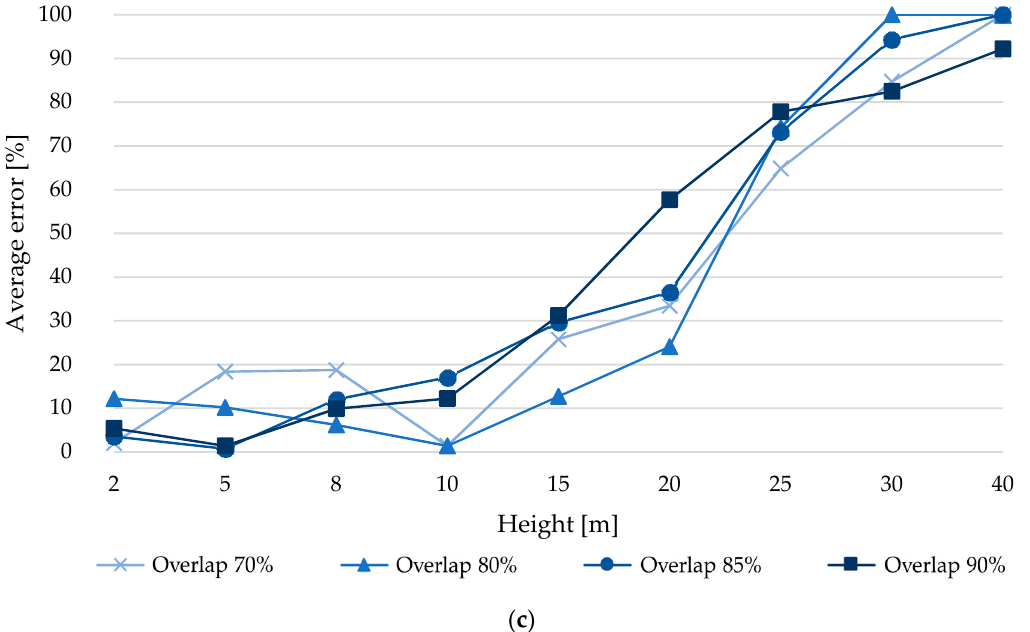
Figure 8. Average relative depth error behavior for different severity levels when varying overlap and height for vertical image acquisition (90°). ( a ) low severity; ( b ) mean severity; ( c ) high severity.